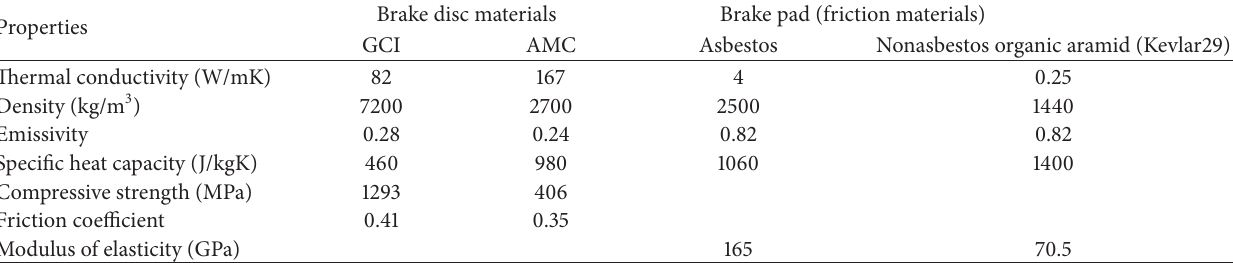
Table 1: Property table of brake disc and pad materials [4, 10–12] and COMSOL Multiphysics 4.0 software material library.